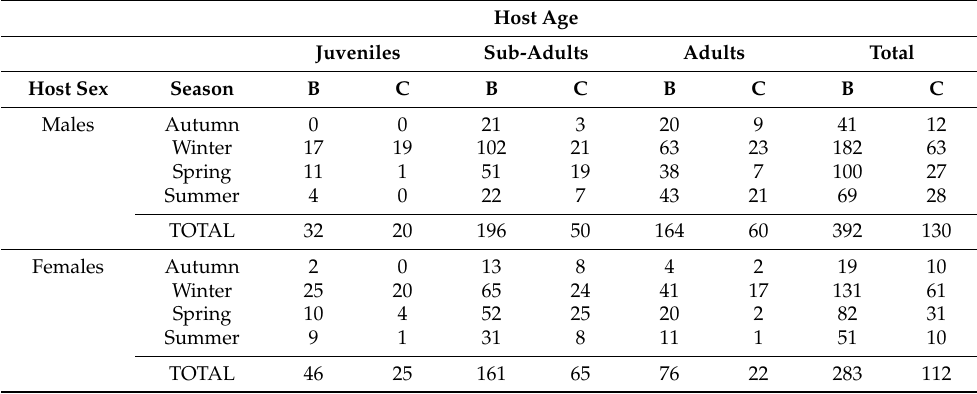
The role played by intrinsic factors (host age and sex, and host population density) and extrinsic factors (site, season and year of capture, and five climate variables) (Table 2) in determining the species richness (expressed through the number of helminth species), and the helminth community diversity (expressed by the five diversity indices) of the wood mouse, as well as the prevalence of the different types of life cycles was analysed. Table 2. Distribution of wood mice analysed by host age and sex and season of capture in the burned (B) and control (C) areas. Host Age